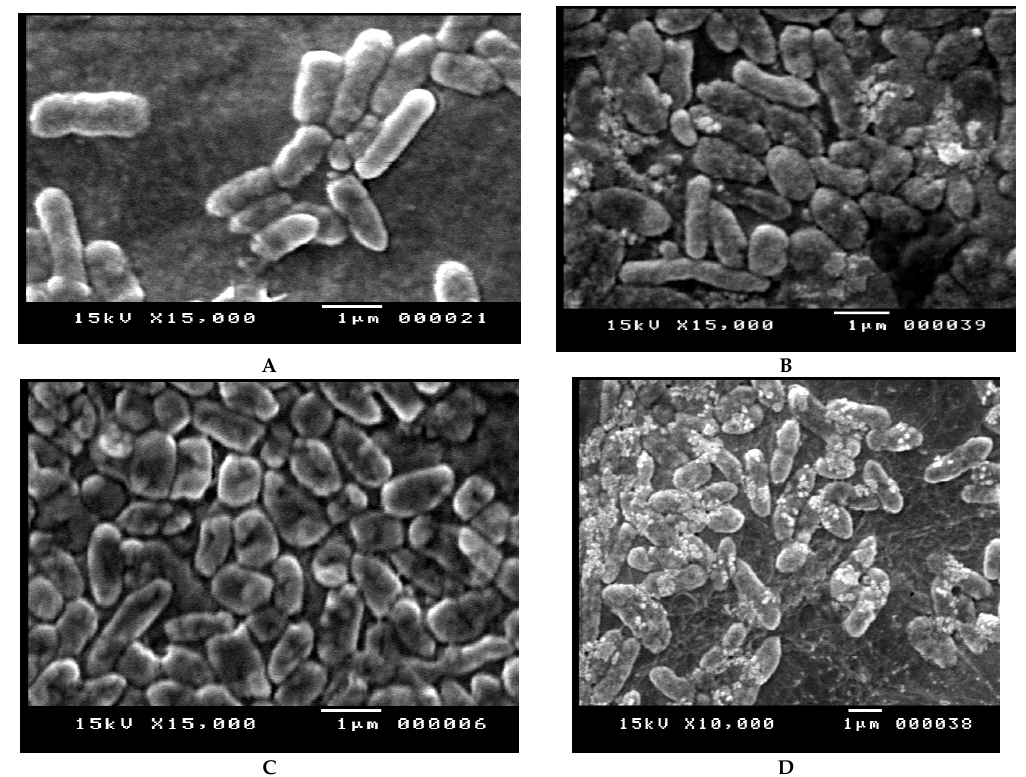
Figure 3. ( A ) SEM image of P. aeruginosa control; ( B ) SEM image of P. aeruginosa treated with imipenem; ( C ) SEM image of P. aeruginosa treated with amikacin; and ( D ) SEM image of P. aeruginosa treated with amikacin/imipenem .